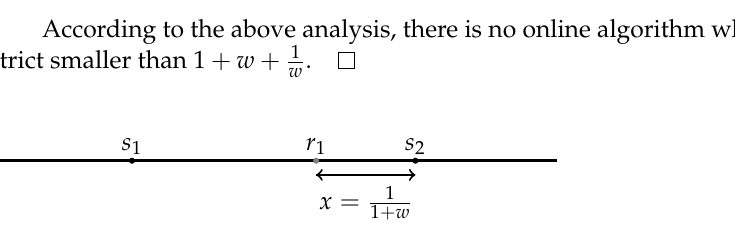
Figure 2. The locations of sensors and